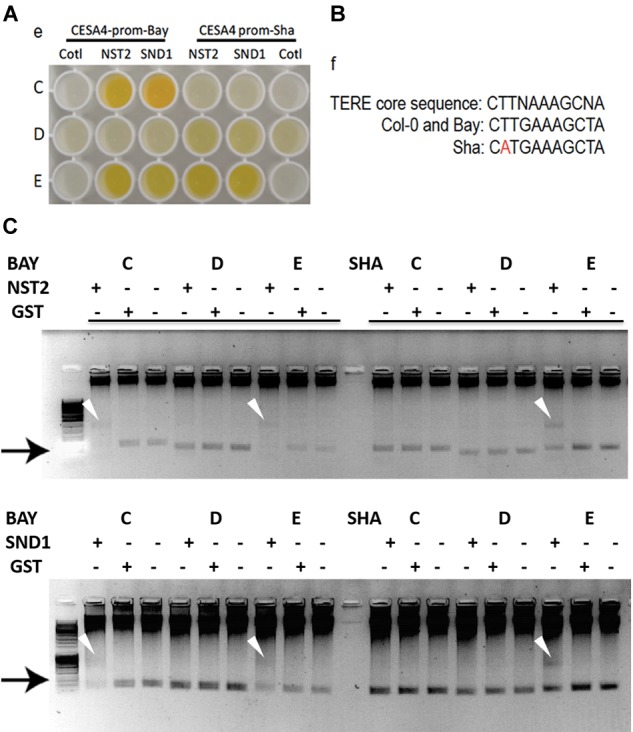
Yeast one-hybrid and protein–DNA interactions within CESA4 promoter. (A) Nine overlapping fragments (A–I) of CESA4Bay and CESA4Sha promoters were screened by yeast one-hybrid with CESA4Col promoter interacting proteins. SND1 and NST2 interacted with two CESA4Bay fragments (C and E) but only a single CESA4Sha fragment (E). (B) A single nucleotide polymorphism disrupts the second position of a perfect TERE motif in CESA4Sha fragment C. (C) Electrophoretic mobility shift assay for interactions between CESA4Bay and CESA4Sha promoters and NST2 and SND1. This polymorphic fragment CESA4Bay fragment C failed to interact with SND1 and NST2.